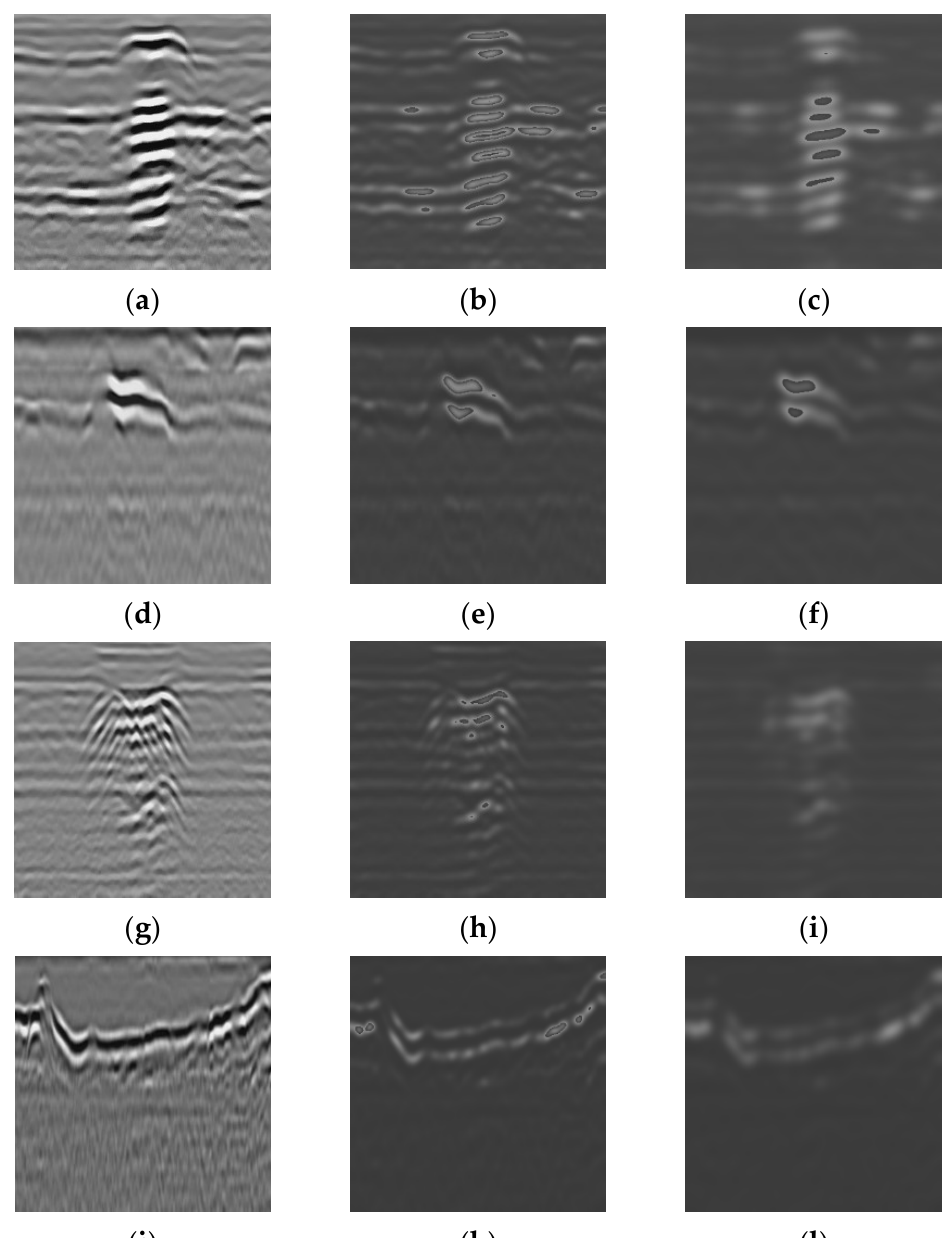
Figure 8. Partial images brightness features pyramid comparison: ( a , d , g , j ) are filtered GPR image 1 to filtered GPR image 4; ( b , e , h , k ) are second-layer brightness features of image 1 to image 4; ( c , f , i , l ) are ninth-layer brightness features of image 1 to image 4.